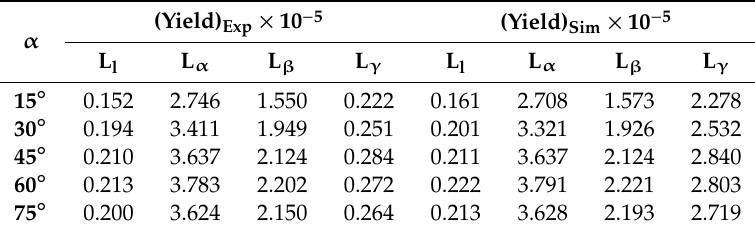
Table 2. Same as Table 1 for impact energy of 20